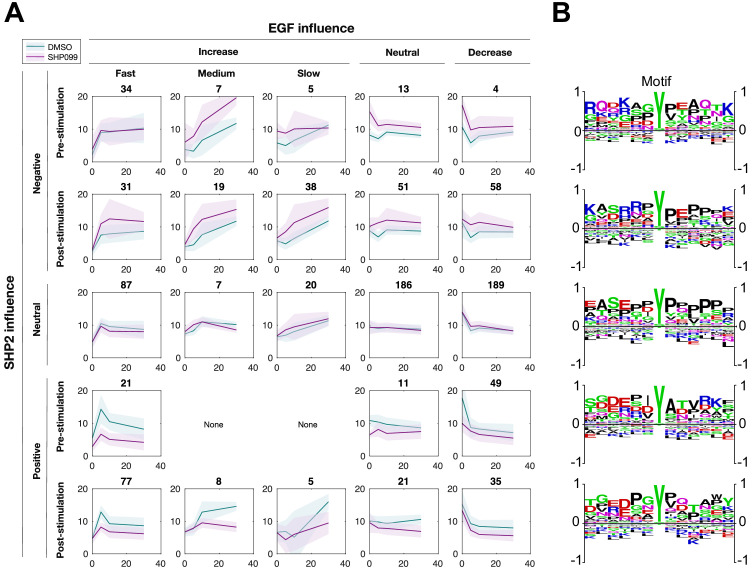
Global analysis of the SHP2 regulated phosphotyrosine proteome.(A) Classification of phosphorylation time courses based on EGFR and SHP2 dependence. Numbers above each plot indicate the number of phosphopeptides within each class combination. (B) Sequence logos (WebLogo, RRID:SCR_010236) showing amino acid preferences at positions flanking the phosphorylated tyrosine residue for each cluster.